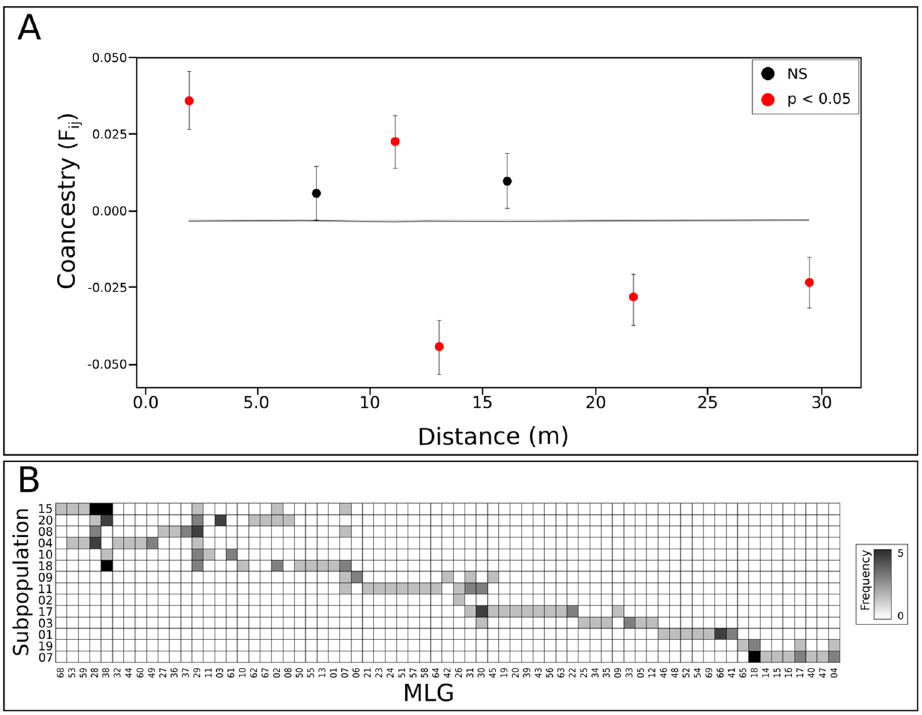
Figure 2. Spatial genetic structure of the empirical Tillandsia recurvata population. ( A ) correlogram from spatial autocorrelation analysis using the correlation coefficient Fij 59 and seven distance classes. The line and the narrow gray area around it represent the expected kinship and 95% confidence intervals of the null hypothesis with no spatial genetic structuring. Black lines around each average F ij value represent their standard errors. ( B ) Adjacency matrix showing the occurrence of each genotype (MLG) of Tillandsia recurvata (columns) on subpopulations corresponding to each sampled tree (rows). Grey gradient colors represent the frequency of each genotype per